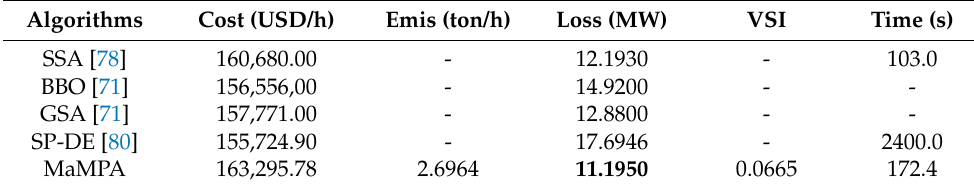
Table 7. Comparison results of case